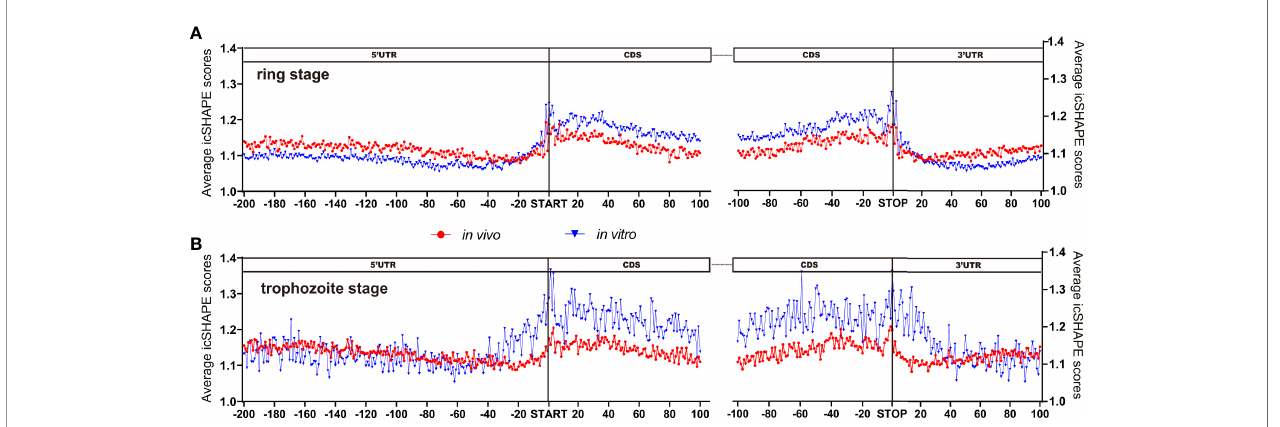
FIGURE 4 | icSHAPE reveals new features of mRNA secondary structures that located 5-UTR, CDS region and 3-UTR region. (Ring stage and trophozoite stage in vivo and in vitro compare) Average icSHAPE scores in selected regions of the whole expressed transcripts across the ring stage ( A for ring stage and B for trophozoite stage) of parasites that have 5 ’ and 3 ’ UTR regions longer than 200 nt: 5 ’ UTR region (200 nt upstream of the start codon); CDS initial region (100 nt downstream of the start codon); CDS fi nal region (100 nt upstream of the stop codon); and 3 ’ UTR region (100 nt downstream of the stop codon) are displayed. The start and stop codons of mRNA transcripts are indicated by grey bars; The fi rst 4 nt immediately upstream of the start codon show signi fi cantly higher reactivity than the average icSHAPE scores across the fi rst 100 nt of the CDS with Signi fi cantly different (Student ’ s t-test, P <